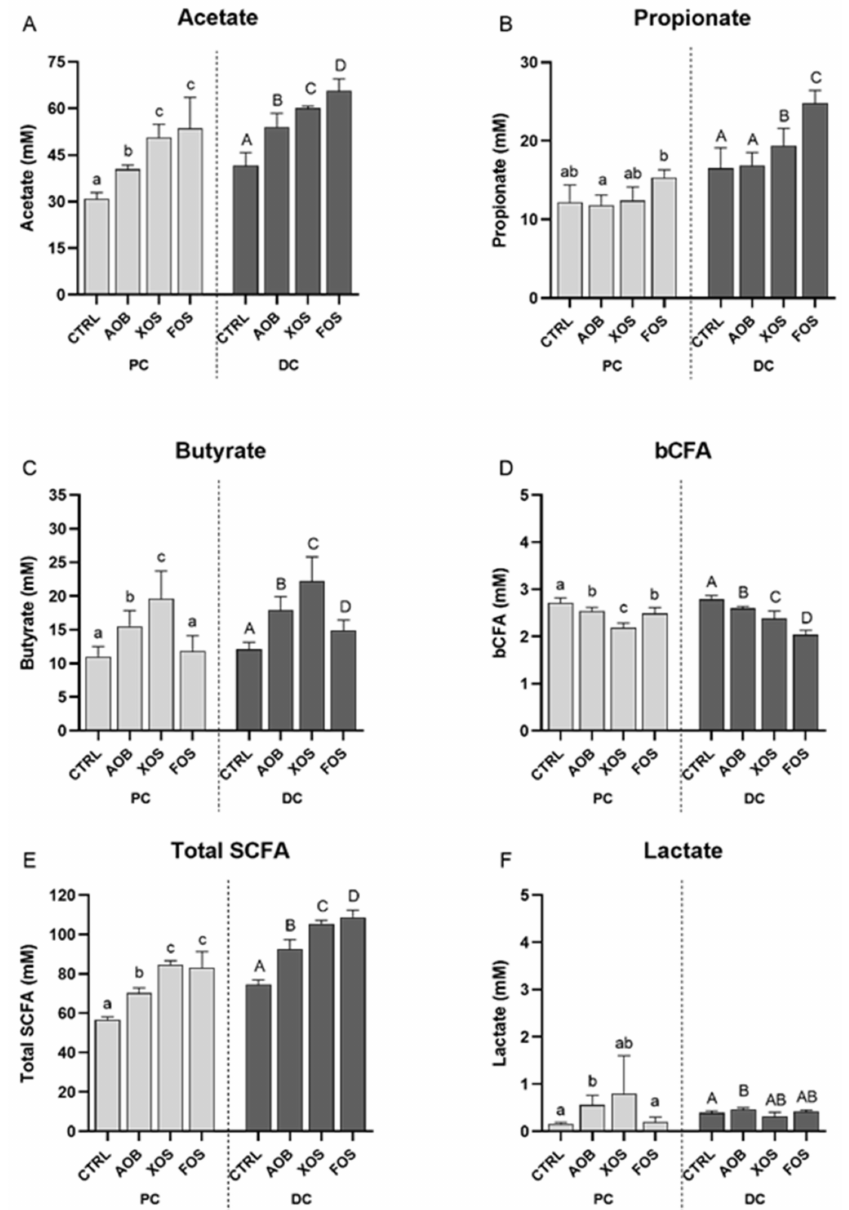
Figure 4. Changes in ( A ) acetate, ( B ) propionate, ( C ) butyrate, ( D ) BCFA and ( E ) total SCFA, and ( F ) lactate for donor 2, upon treatment with AOB, XOS and FOS versus a blank control for PC and DC. Bars represent the average and standard deviation of four treatment days (D3/4/10/11) ( n = 4). CTRL = control; AOB = antioxidant blend; XOS = xylooligosaccharides; FOS = fructooligosaccharides; PC = proximal colon; DC = distal colon; BCFA = branched-chain fatty acids; SCFA = short-chain fatty acids. Significant differences are indicated with different letters (a, b, c, A, B, C, D; p <